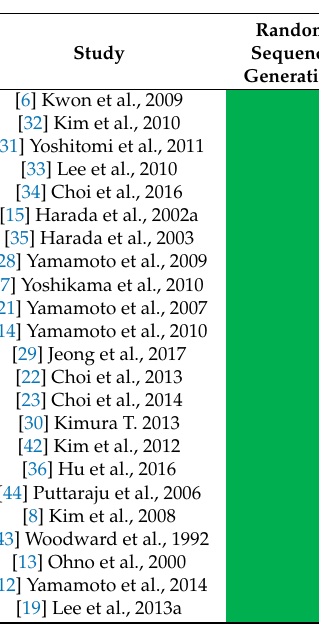
Table 2. Risk of bias rating of each